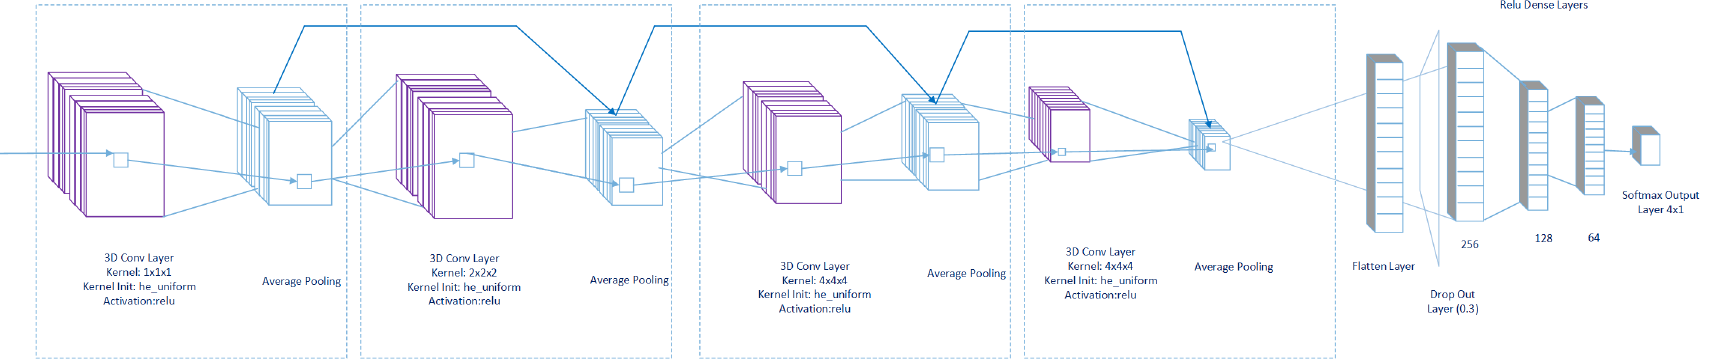
Figure 5. ALT-CNN-DENSE Net proposed architecture for multiclass (lung cancer pathology or stage)